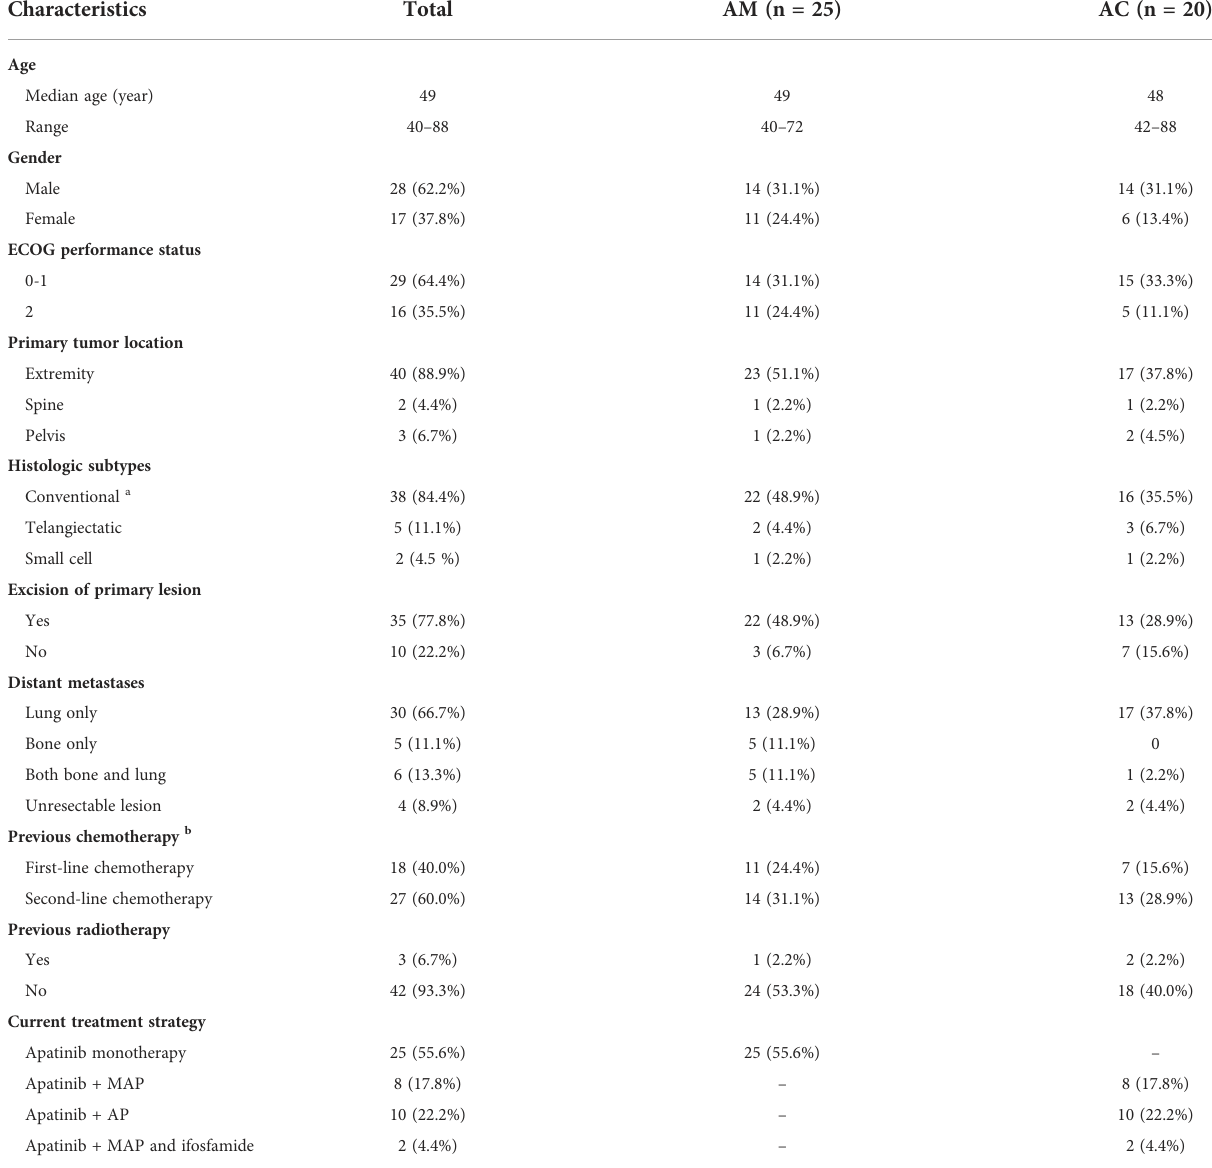
TABLE 1 Clinical baseline characteristics of the patients with metastatic